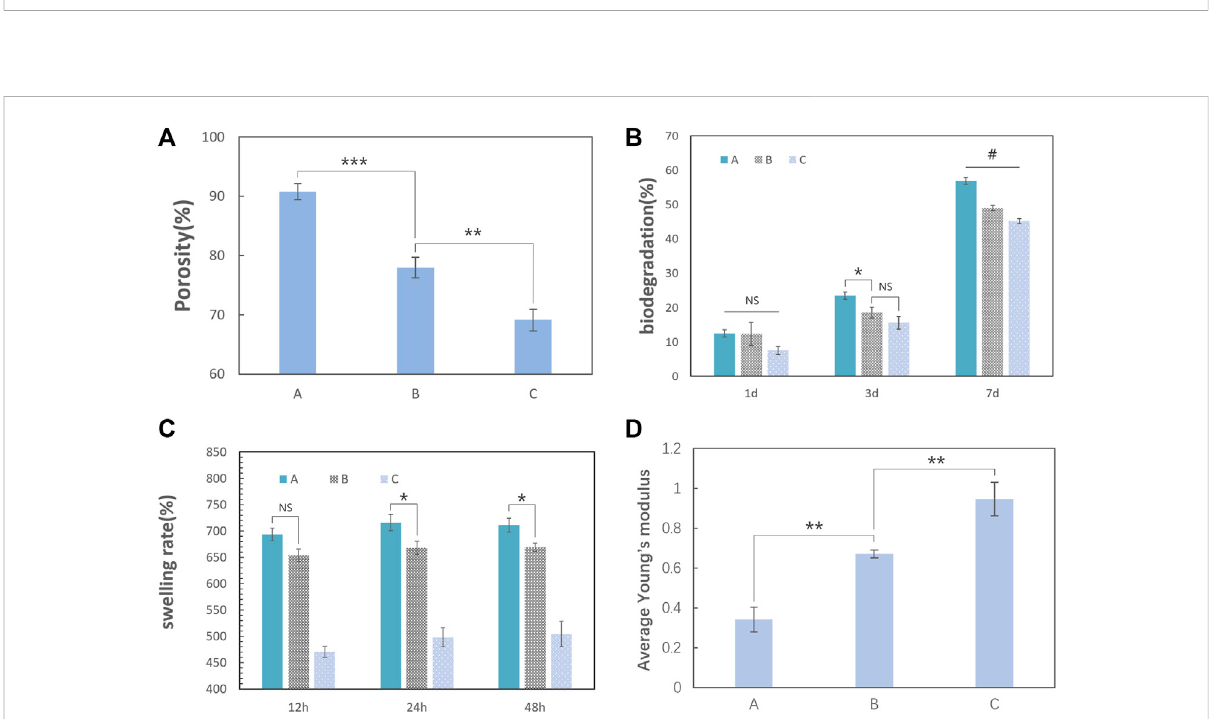
FIGURE 6 Physical properties of the nanocomposite scaffolds (the error bar represents the standard deviation of the samples). (A) Testing the porosity of the scaffold by the drainage method; the last column of data was the average porosity of the three groups. Group A was 91.4%, group B was 78.8%, and group C was approximately 70.0%. The porosity of the scaffold decreased gradually with the increase in the TCP content (one-way ANOVA, F = 130; p < 0.0001; n = 3). (B) Biodegradation of the three groups at 7 days. The percentage degradation values of the three groups in a type I collagenasesolutionfor7 dayswereapproximately56.9%forgroupA,49.0%forgroupB,and45.1%forgroupC.WithanincreaseintheTCPcontent in the scaffold, the degradation rate on the 7th day gradually decreases (one-way ANOVA, F = 149.8, p < 0.001, and n = 3). (C) Swelling rate for the three groupsin 48 h. The scaffolds had aconsiderable swelling ratio and reached itspeak atgroup A (715.8%) in24 h(one-way ANOVA, p < 0.05, n = 3). (D) Average Young ’ s modulus of the scaffold tested in dry conditions. Group A was 0.946 MPa, group B was 0.671 MPa, and group C was 0.342 MPa. Young ’ s modulus of the scaffolds increased with the HCP content (one-way ANOVA, F = 72.72, p < 0.0001, and n = 3). ( “ # ” represents a signi fi cant difference between each group; * p < 0 .05; ** p < 0.01; *** p < 0.001; **** p < 0.0001; “ NS ” represent no signi fi cant differences between each